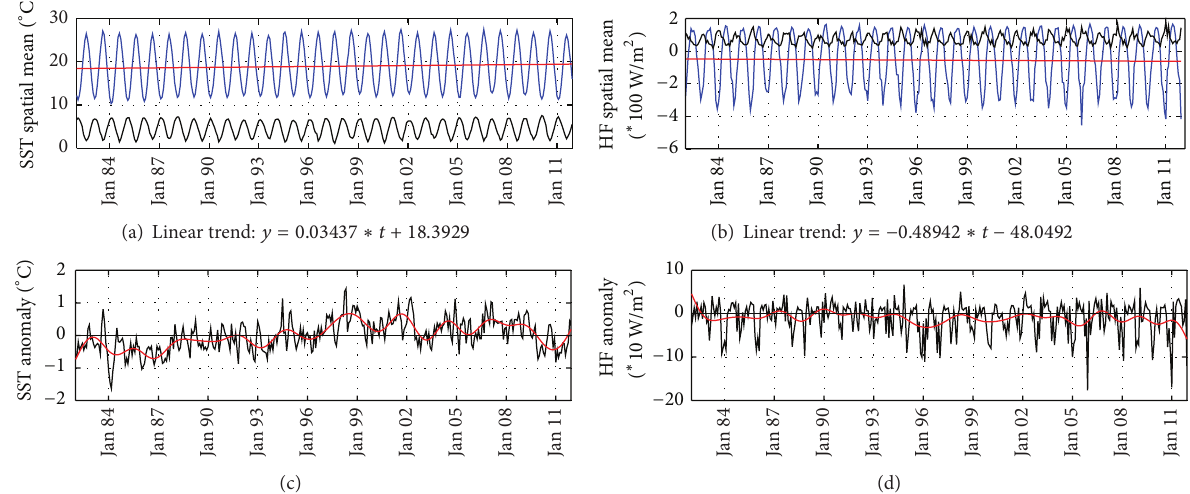
Figure2:Temporalevolutionofthespatialaverageofthemonthlyvalues(blueline)andlongperiodtendency(redline)anditscorresponding standard deviation (black line) for SST (a) and the surface net heat flux (b). Monthly mean values of the spatial anomaly with respect to the climatological annual cycle (black line) and series with low-pass-filter ( > 2 years) (red line) for SST (c) and the net surface heat flux